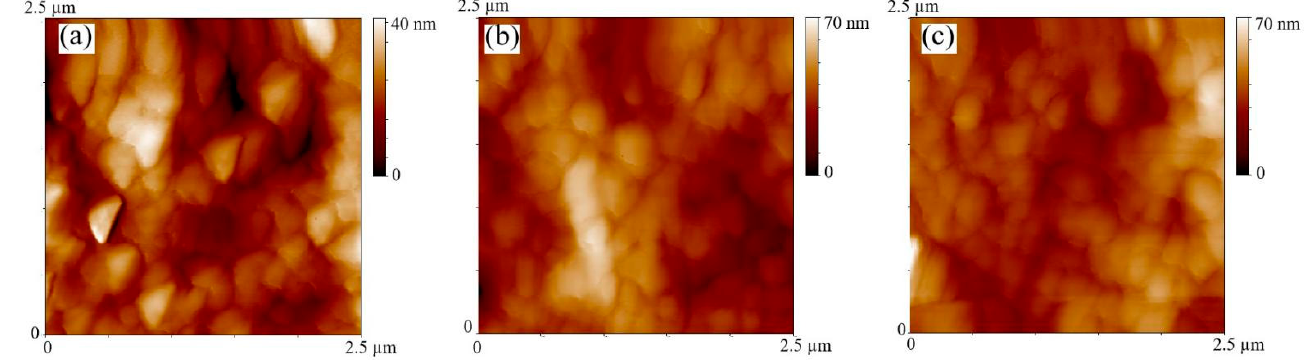
Figure 5. Surface morphology of the P3HT:PCBM film with PEIE ( a ) and 1-LiCl/PEIE ( b ) or 5-LiCl/PEIE ETL ( c ). The scan size is 2.5 μ m × 2.5 μ m.